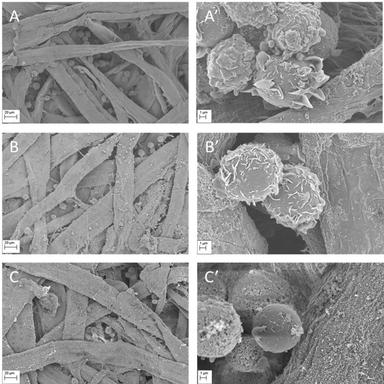
Scanning electron micrographs of filtering papers coated with: A, A′ – PPy, B, B′ – PPy–Au, C, C′ – PPy–Ag with incubated monocytes THP-1 cells line.